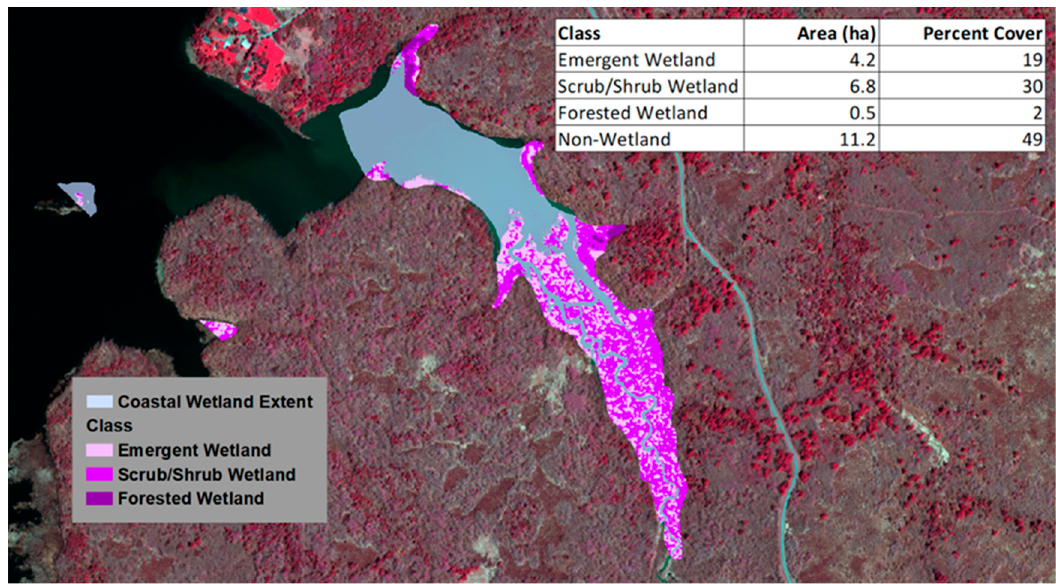
Figure 9. A summary of the area and percent cover for each wetland class within a wetland polygon. The Western Lake Superior region imagery was processed in batch and parallel using eCognition Developer (Trimble). These results were then manually reviewed and used to construct bar plots showing wetland area for the range of dates in the imagery archive and all of the wetland polygons (n = 192) in the Western Lake Superior region (Figure 10). The Western Lake Superior region had 188,430 unique wetland polygons that cover 13,928.6 ha. This wetland product was created to integrate an existing wetland product used by stakeholders with up-to-date, value-added information. The next phase of the project will extend the wetland mapping to the entire basin and all GLCWI polygons.